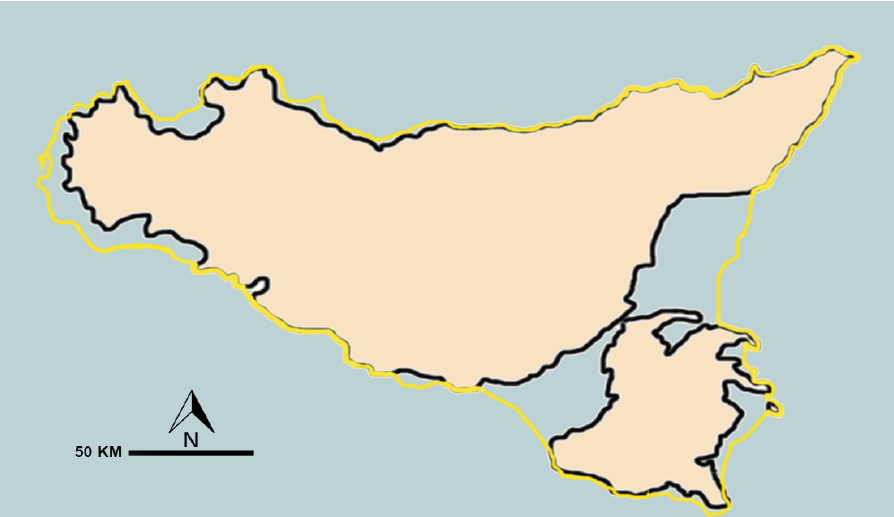
Figure 4. Palaeogeography of Sicily in the middle Pleistocene against present-day coastline (yellow contour). The Hyblean Plateau formed an island separated from the rest of Sicily (from [27], modi- fied).